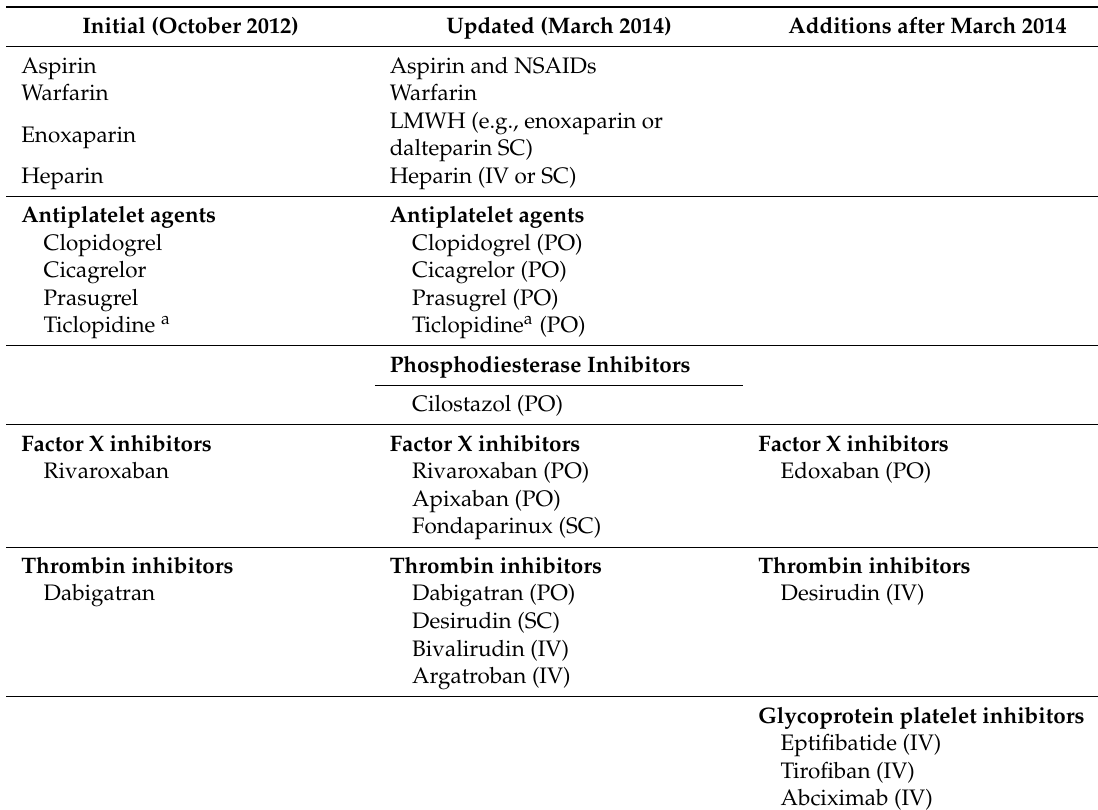
Table 2. Initial and updated anticoagulation medication